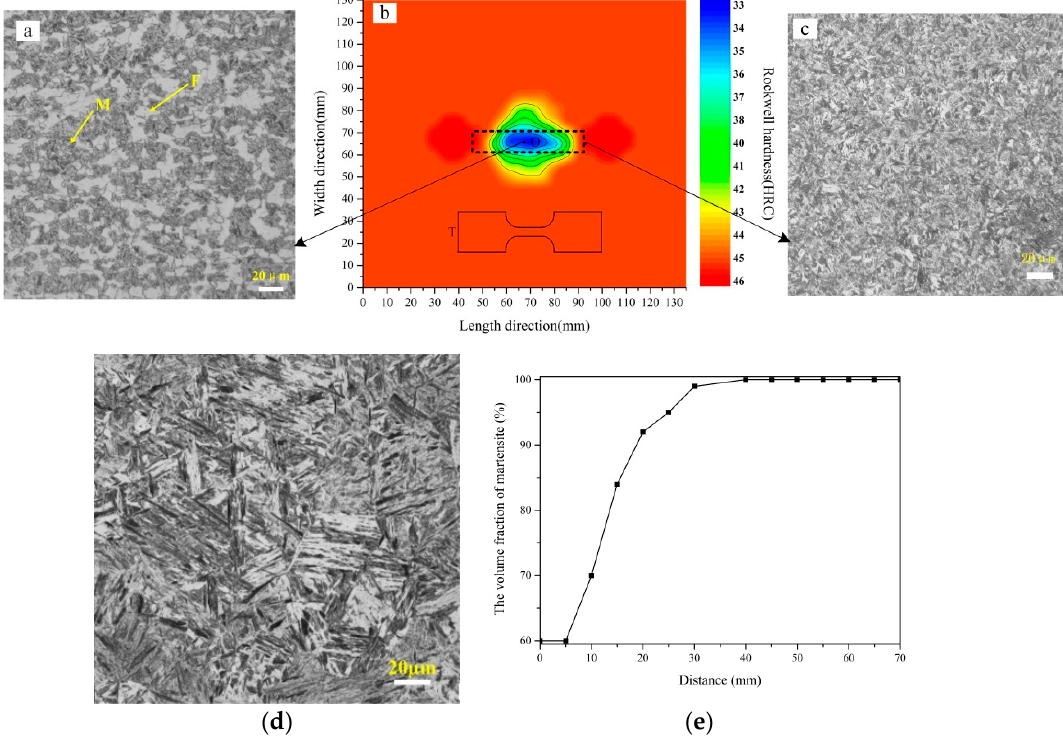
Figure 5. The hardness distribution, optical microscope (OM) images, tensile specimen size and location, the martensite volume fraction. ( a ) Mixture microstructure in the lower-temperature region; ( b ) the hardness distribution and tensile location (O and T); ( c ) martensite in the higher-temperature region; ( d ) martensite obtained by conventional heating–water quenching; and ( e ) martensite volume fraction along the horizontal positive direction from the blank center.